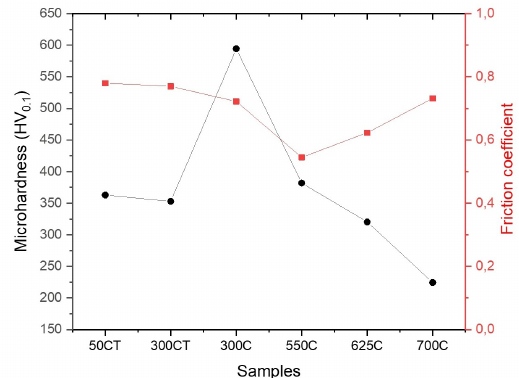
Figure 7. Friction coefficient after running in period in pin on disc tests.